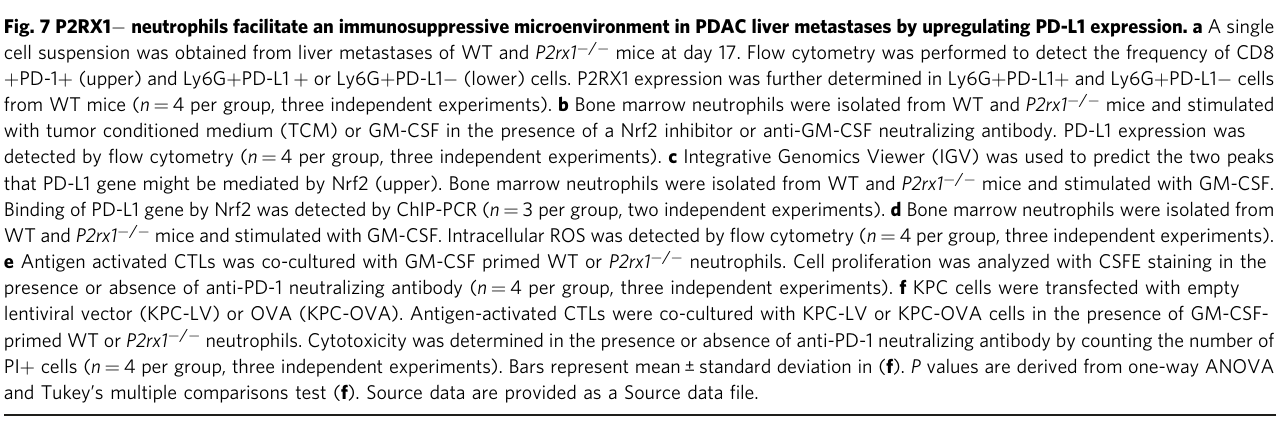
Fig. 7 P2RX1 − neutrophils facilitate an immunosuppressive microenvironment in PDAC liver metastases by upregulating PD-L1 expression. a A single cell suspension was obtained from liver metastases of WT and P2rx1 − / − mice at day 17. Flow cytometry was performed to detect the frequency of CD8 + PD-1 + (upper) and Ly6G + PD-L1 + or Ly6G + PD-L1 − (lower) cells. P2RX1 expression was further determined in Ly6G + PD-L1 + and Ly6G + PD-L1 − cells from WT mice ( n = 4 per group, three independent experiments). b Bone marrow neutrophils were isolated from WT and P2rx1 − / − mice and stimulated with tumor conditioned medium (TCM) or GM-CSF in the presence of a Nrf2 inhibitor or anti-GM-CSF neutralizing antibody. PD-L1 expression was detected by fl ow cytometry ( n = 4 per group, three independent experiments). c Integrative Genomics Viewer (IGV) was used to predict the two